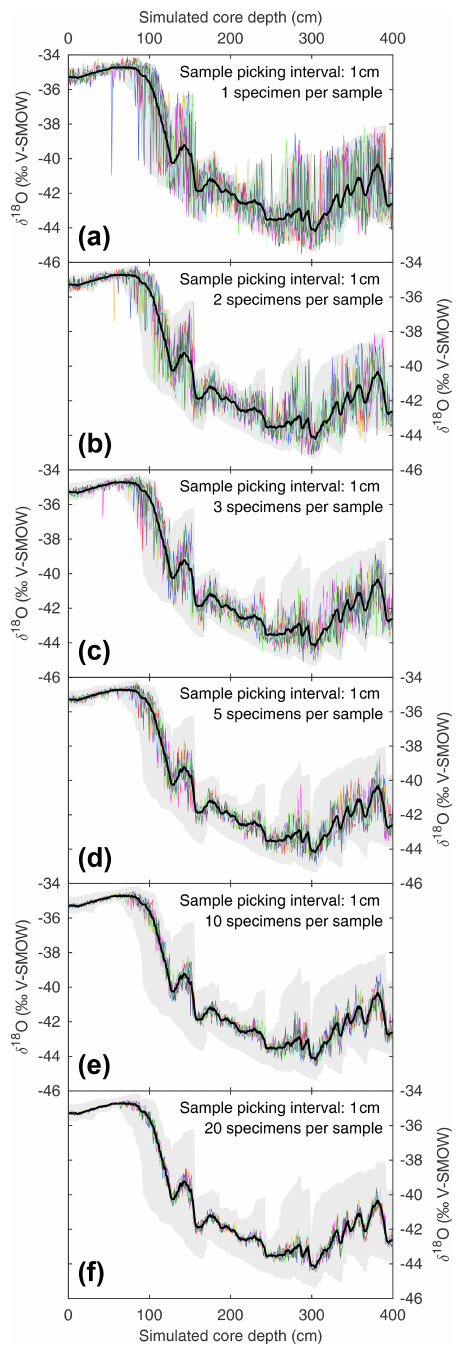
Figure 4. Estimating noise induced by subsample size during the picking process. Based on the SEAMUS simulation in Fig. 1b, six sample size scenarios are considered: (a) 1 specimen per sample; (b) 2 specimens per sample; (c) 3 specimens per sample; (d) 5 specimens per sample; (e) 10 specimens per sample; (f) 20 specimens per sample. In each scenario, the downcore picking process is repeated 10 times, and each picking run is represented by a coloured line. Also shown in all panels is the mean δ 18 O value for all single specimens within discrete-depth intervals (black line) and 95.45% intervals (filled grey